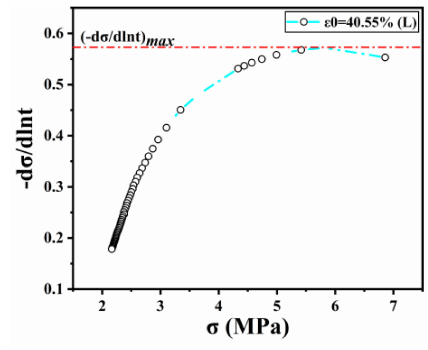
Figure 10. Curve of − d σ /d lnt versus σ